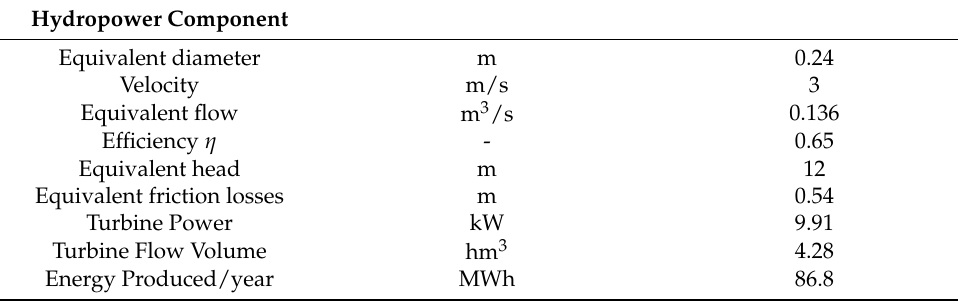
Table 3. Hydropower component of the Hy4REN hybrid